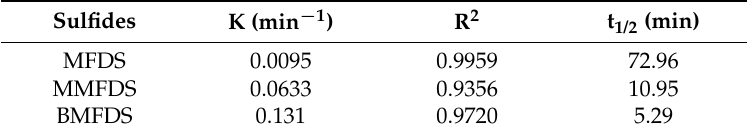
Table 2. Degradation kinetics parameters of β -carotene in the presence of BMFDS, MMFDS, MFDS under UVA irradiation in ethanol system. Sulfides